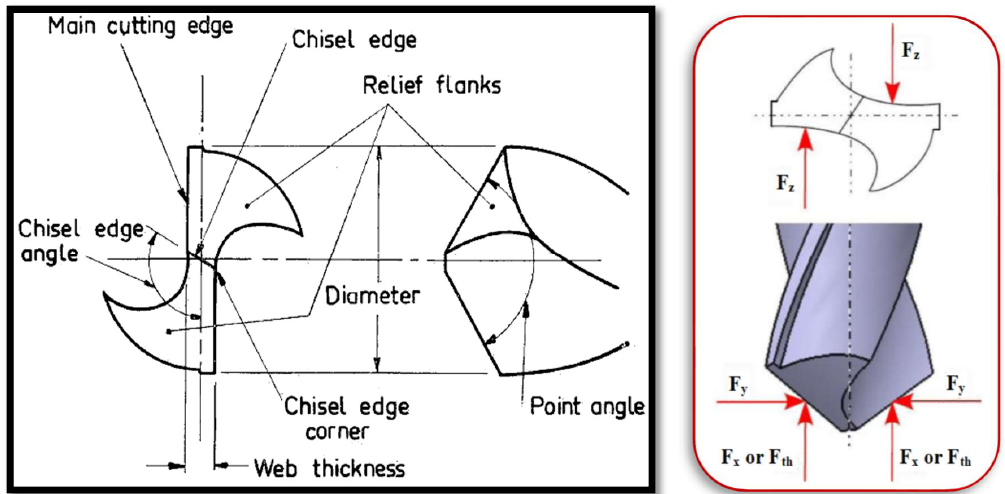
Fig. 3. Cutting edge geometry of a drill and Cutting forces during